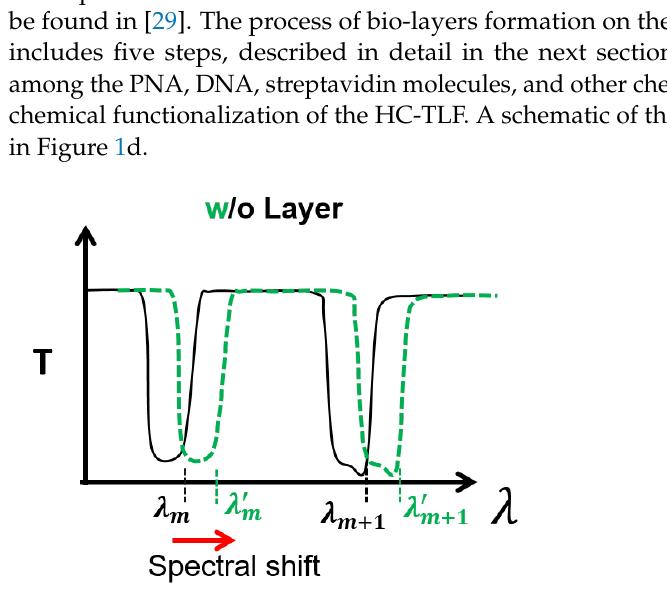
Figure 2. The sketched T spectrum shift due to the bio-layer binding of the inner surface of the fiber. The presence or absence of bio-layer has been shown, respectively, with w (green) and without o